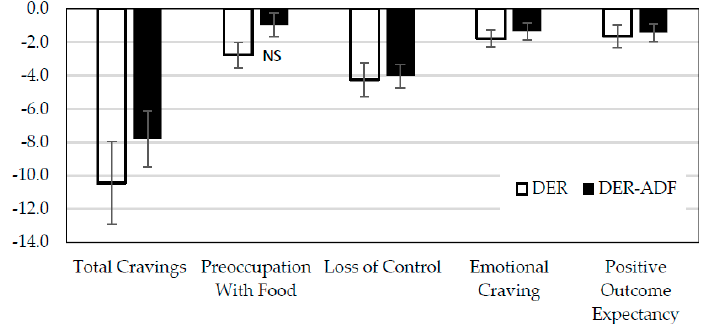
Figure 4 . Food Craving scores for those in the DER and ADF + DER groups. Note: scores based on Trait Food Craving Questionnaire: Total caving scores range min 21, max 126; Preoccupation with Food min 6, max 36; Loss of Control min 6, max 36; Emotional Craving min 4, max 24; Positive Outcome